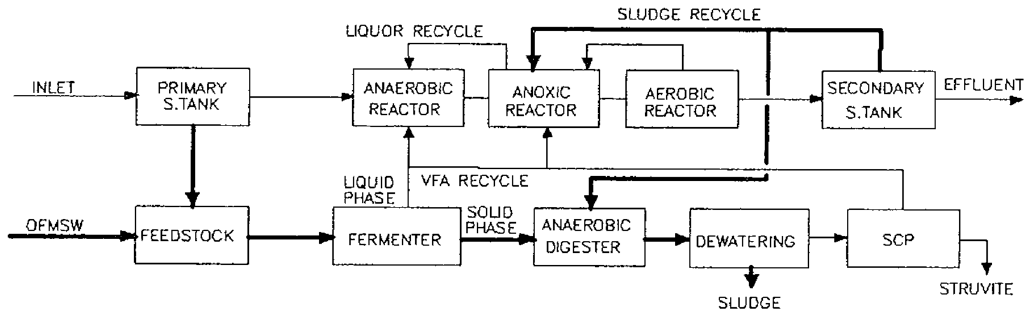
Figure 1. Integrated wastewater and waste treatment scheme [11].